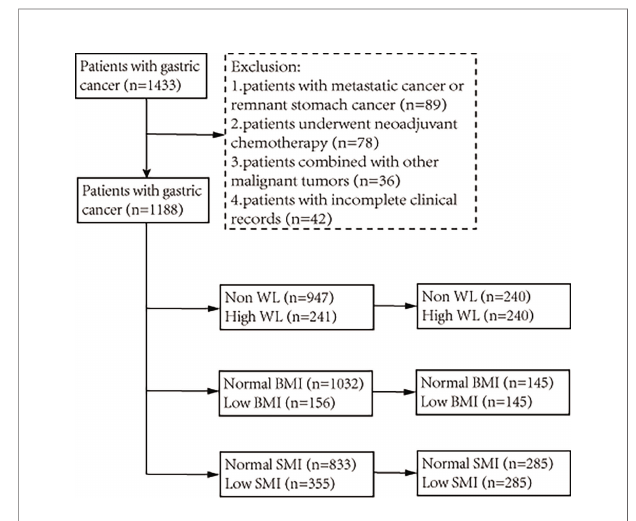
FIGURE 1 | The fl owchart of patient